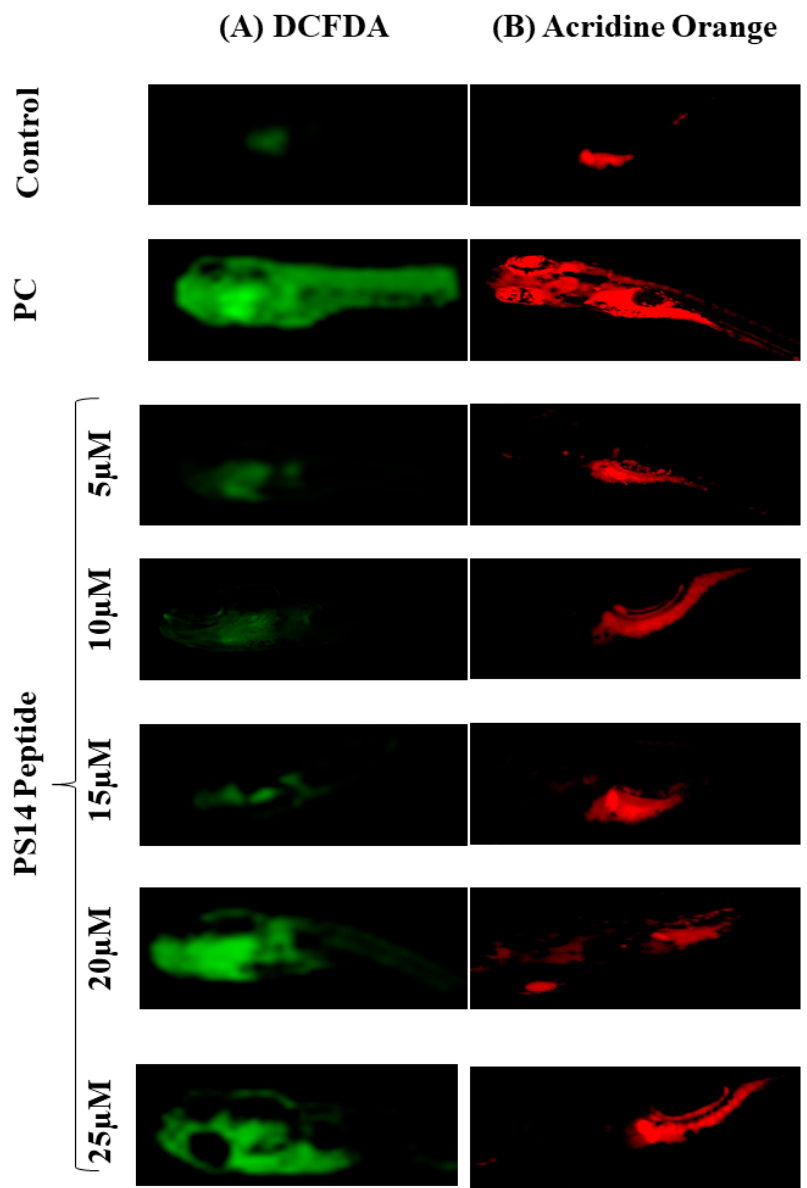
Figure 3. Fluorescent imaging of 96 hpf zebrafish larvae treated with PS14 along with untreated control and positive control (PC) treated with 1mM of H 2 O 2 . ( A ) Intercellular ROS measurement by DCFDA; and ( B ) Apoptosis detected by acridine orange.